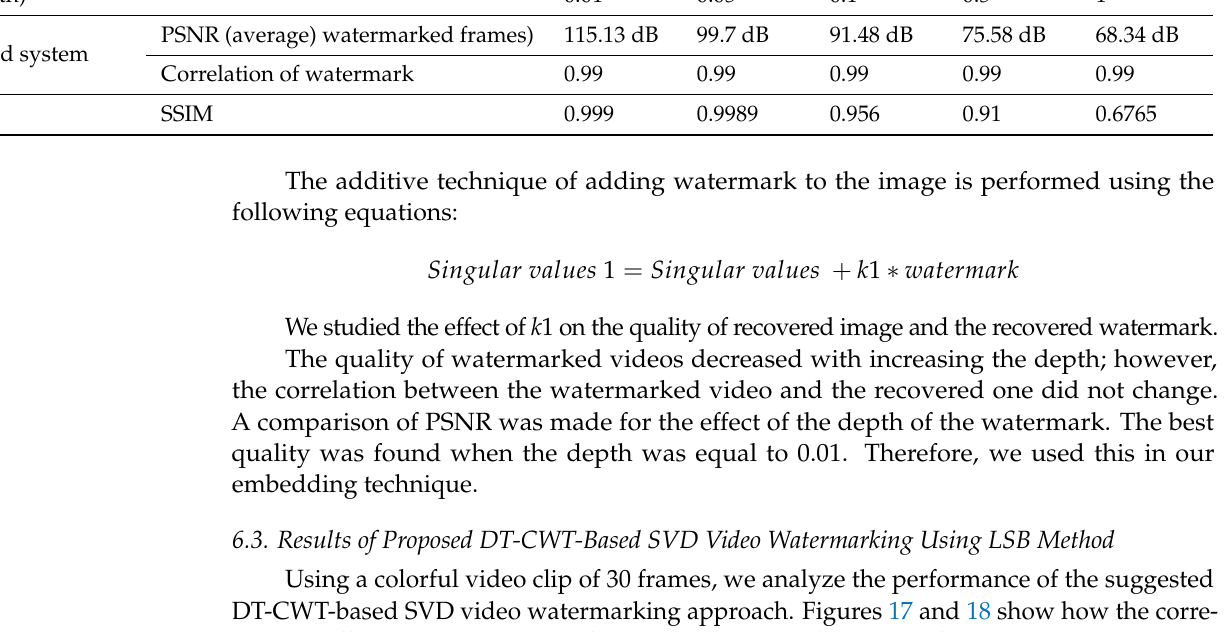
( b ) Extracted watermark from frame 10 of second video in the proposed method ( c ) Extracted watermark from frame 10 of the second video scene in the DWT-based SVD method. ( d ) Correlation values for the extracted watermarks from each frame in the second video scene under histeq attack.